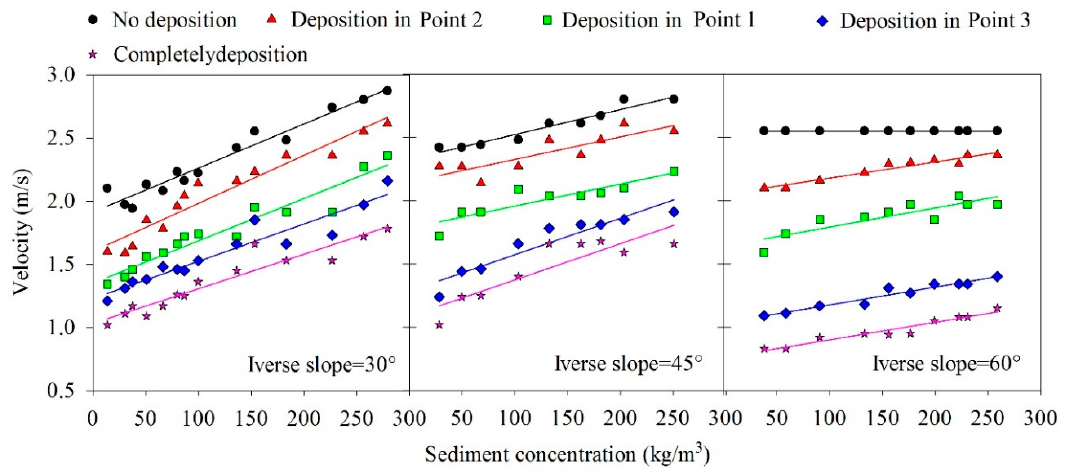
Figure 4. Critical deposition velocities under different sediment motion conditions in each group.